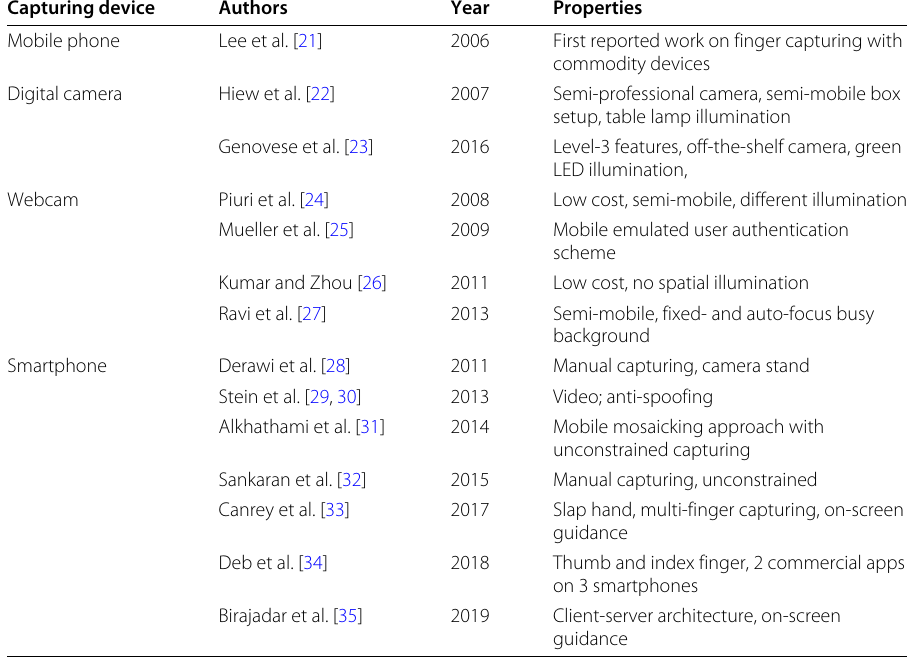
commodity devices